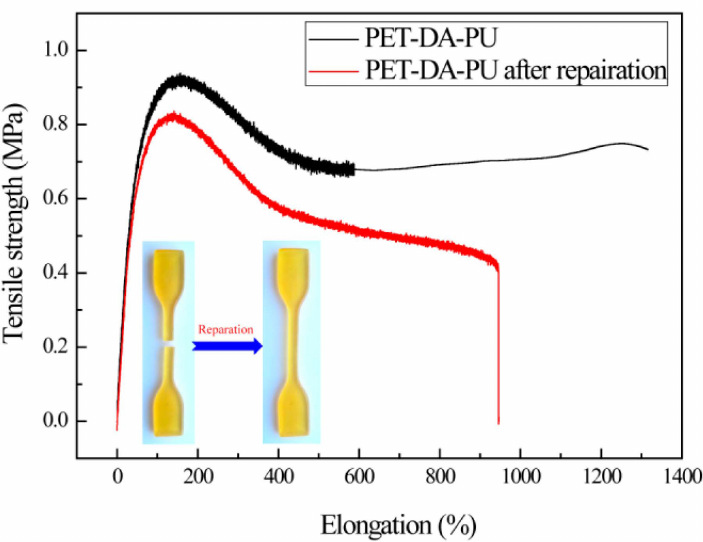
Figure 5. Mechanical property of PET-DA-PU and its damaged and healed